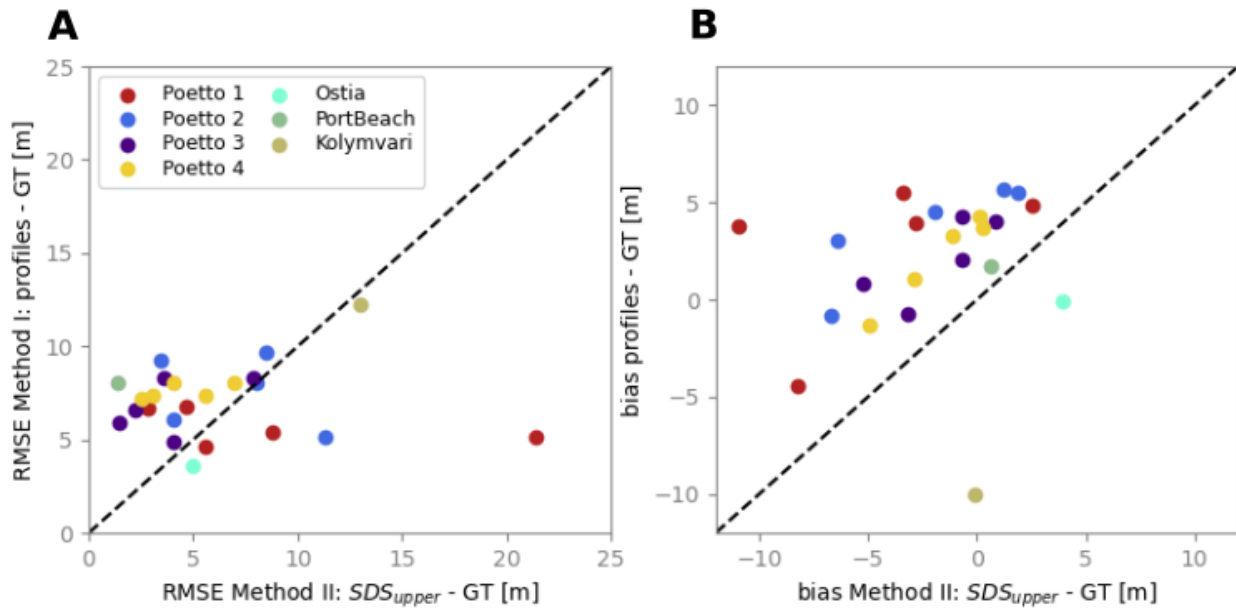
Figure 10. Comparison of the RMSE ( A ) and the bias ( B ) of the SDS profile and SDS upper